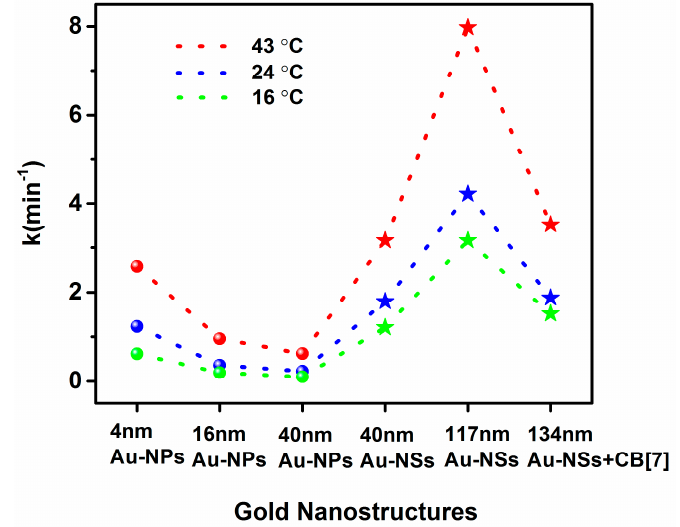
Figure 3. The apparent reaction rate constant ( k app ) obtained from the linear fit of 4 ‐ NP catalysis over time. Table 1. Summary of the apparent rate constant ( k app ), induction time ( t 0 ) at three different temperatures, and the apparent activation energies ( E a ) for gold nanoparticles in this work.